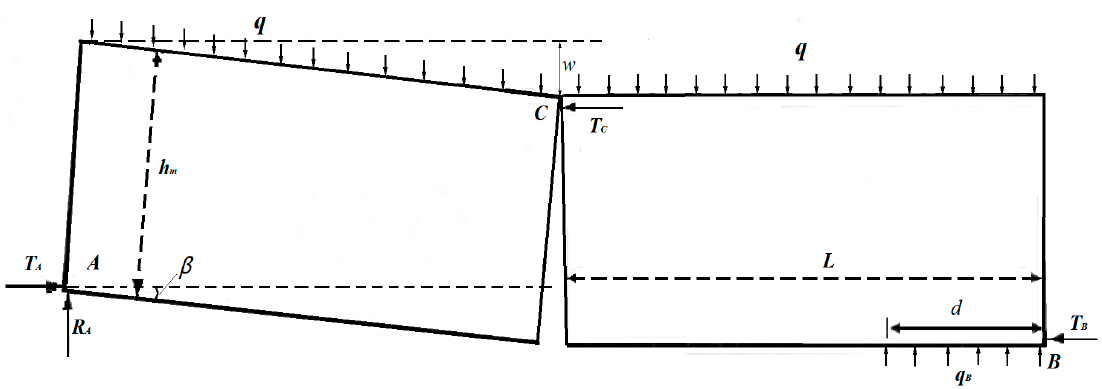
Figure 1. Force analysis of the basic structure of the key stratum failure.